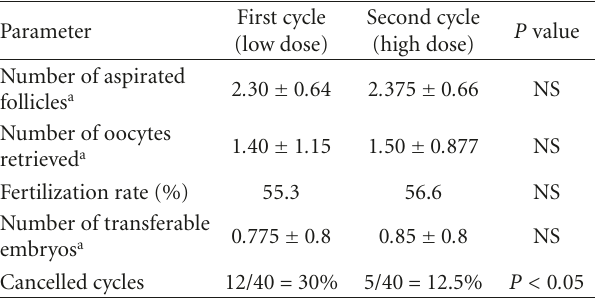
Table 2: Comparison of two consecutive cycles which dose of rFSH has been